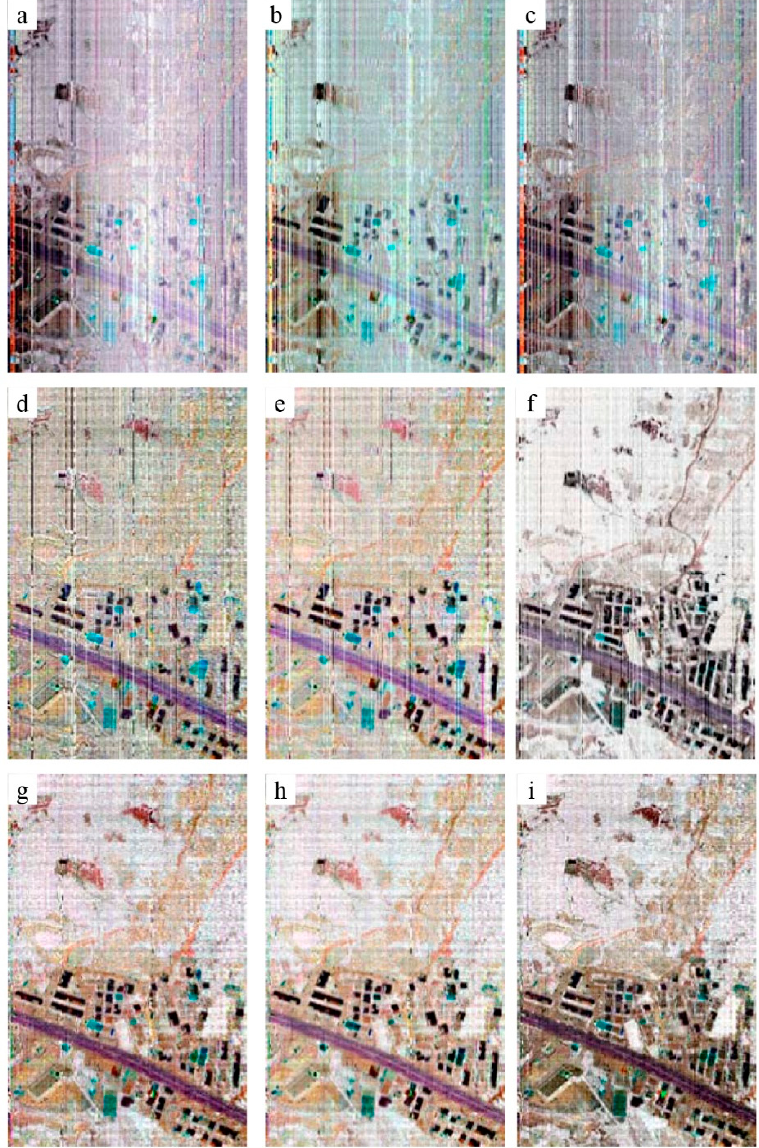
Figure 9. The emissivity retrieved by the commonly used TES algorithms based on the ATHIS data before ( a – c ) blind pixel repair, ( d – f ) blind pixel repair by GB/T 17444-2013 method and ( g – i ) blind pixel repair by proposed method. ( a , d , g : ARTEMISS; b , e , h : WTTES; c , f , i : RDSS.).